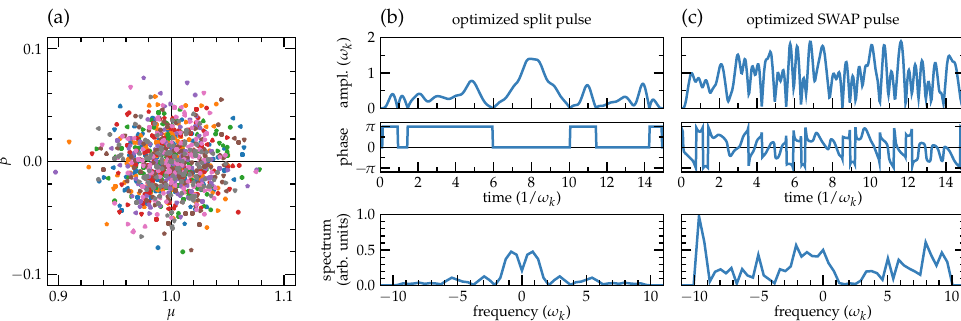
Figure 6. ( a ) Ensemble points used for the optimization. The sampling points were chosen from a normal distribution around µ = 1 and β = 0, with a width of ∆ µ = ∆ β = 0.025, divided into 64 batches with 16 points per batch. The different batches are distinguished by the combination of color and marker shape. ( b ) Optimized pulse amplitude, phase, and spectrum for the initial ( + i ) / √ 2. ( c ) Optimized pulse amplitude, phase, and spectrum for the splitting pulse 0 0 1 | (cid:105) → | (cid:105) | (cid:105) central swap pulse between 0 and 1 . For Rb-87 and a laser wavelength of 780 nm, the two-photon | (cid:105) | (cid:105) recoil frequency is ω k = 2 π 15.1 kHz. The unit of time 1/ ω k corresponds to roughly 10 − 5 s. Thus, · the duration of the shown pulses is on the order of 150